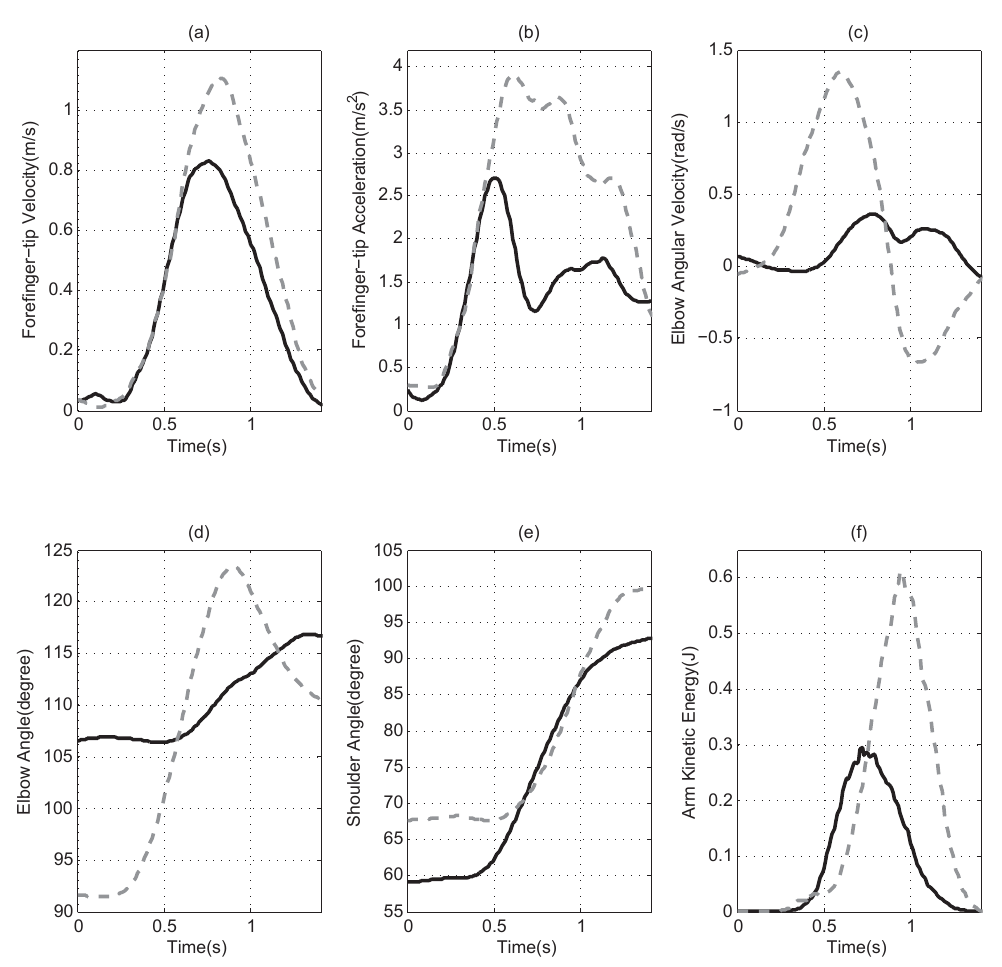
Figure 7: Measured kinematic and energy property profiles of two trajectories in Case A : (a) forefinger-tip velocity, (b) forefinger-tip acceleration, (c) elbow angular velocity, (d) elbow joint angle, (e) shoulder joint angle, (f) arm kinetic energy